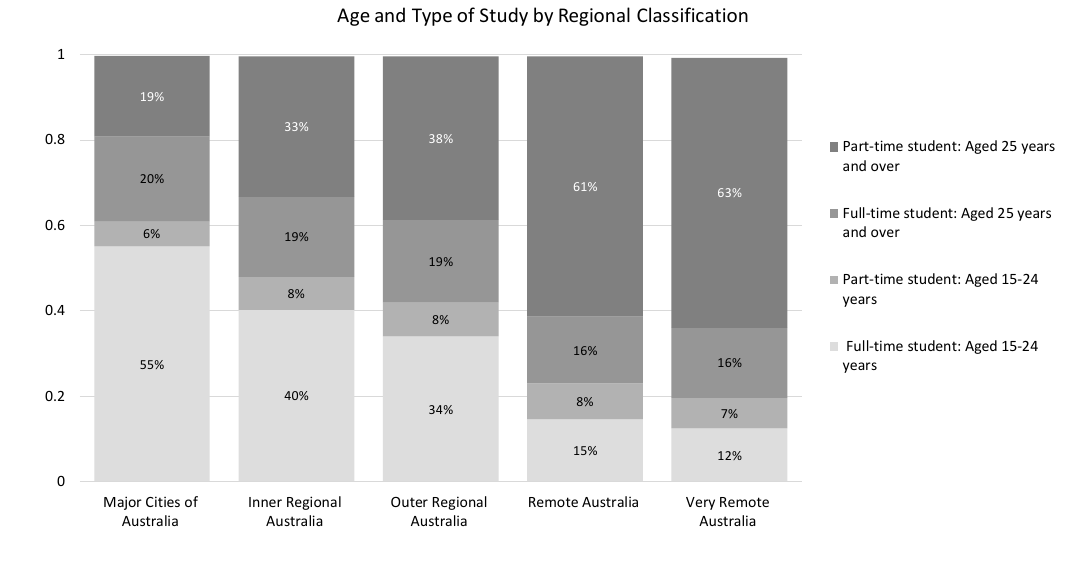
Figure 4. Age and type of study by regional classification (ABS.